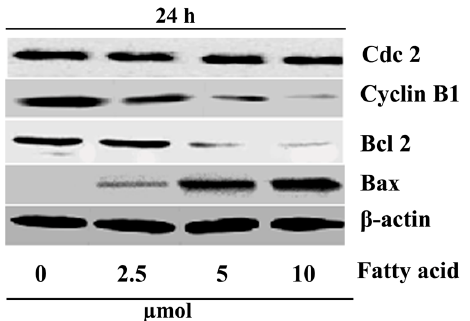
Figure 5. Western blot analysis of expression of proteins involved in apoptosis and G 2 /M arrest of HepG2 cells exposed to A. spinosus fatty acid. HepG2 cells were treated with several concentrations (0–10 µmol/L) of fatty acid for 24 h, which altered the expression of various proteins.